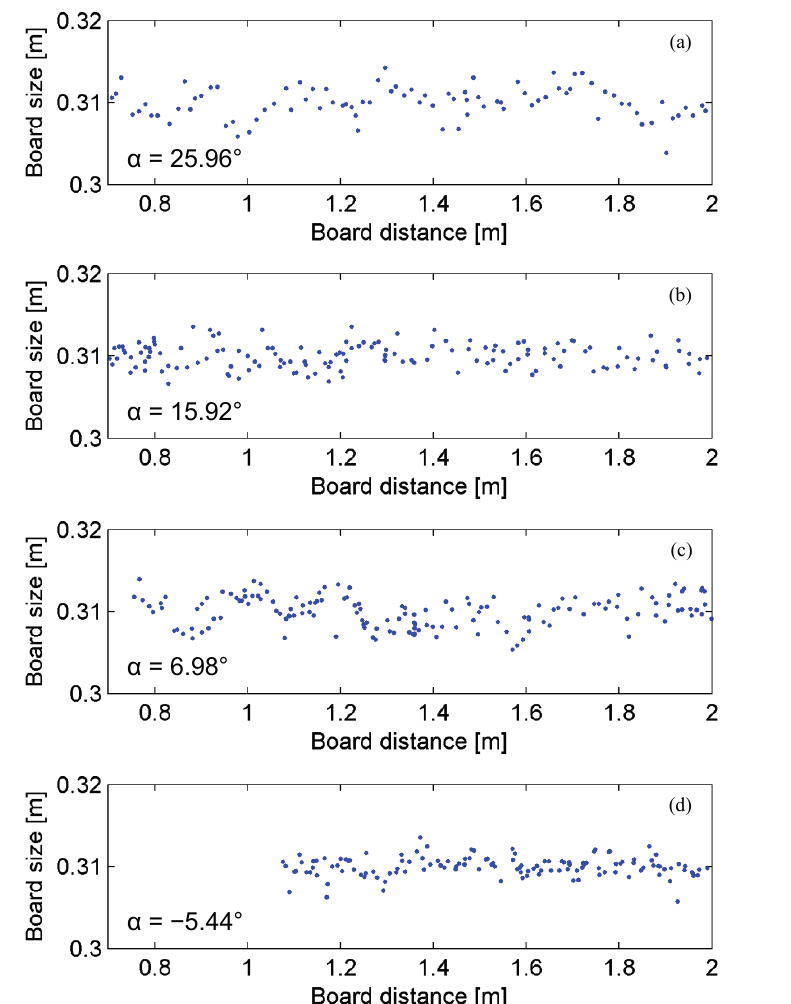
Figure 12. Estimation of the size of the sample board as a function of the distance of the target from the light sources. Measurements have been performed changing the direction of the radial shifts, accordingly with the axis defined by the angle α , referred to the ground plane: ( a ) α = 25.96°; ( b ) α = 15.92°; ( c ) α = 6.98°; ( d ) α = −